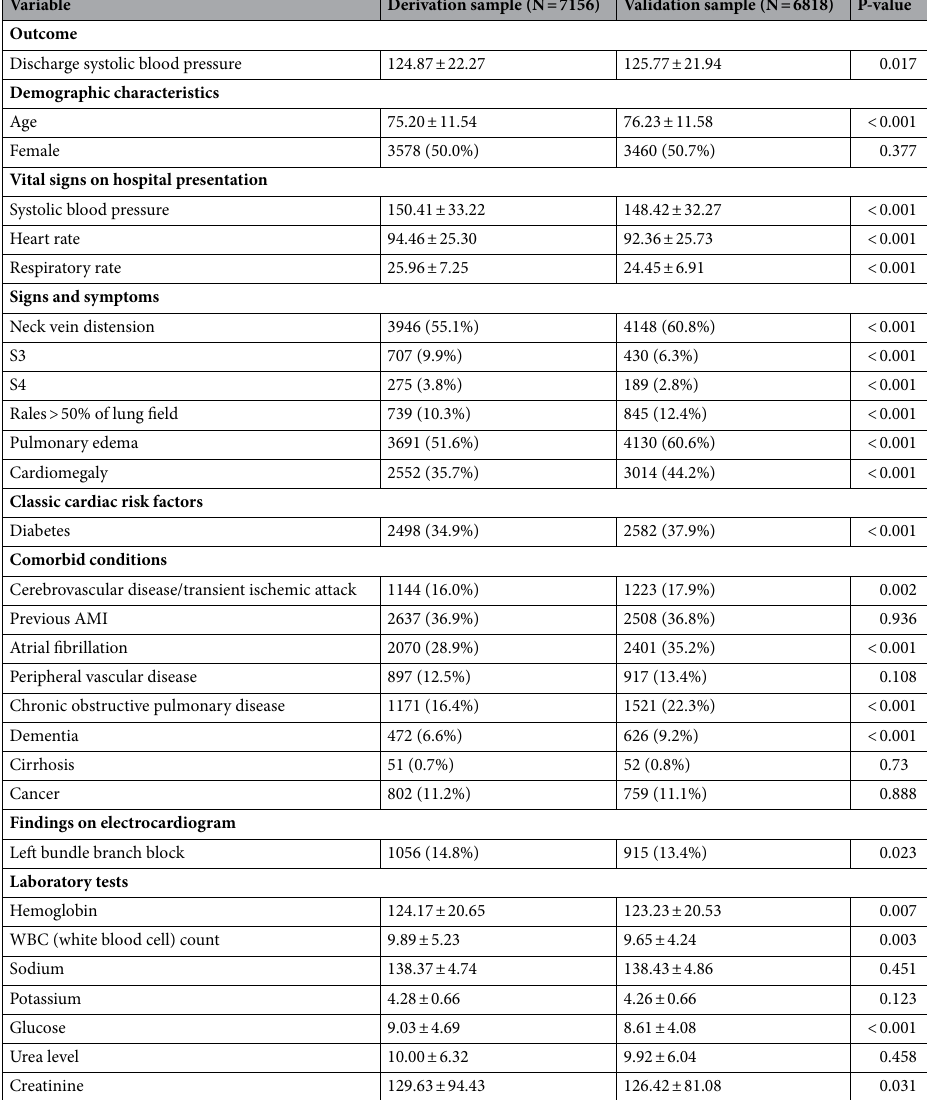
Table 2. Baseline characteristics of patients in the CHF derivation and validation samples. Continuous variables are reported as mean ± standard deviation, while binary variables are reported as N